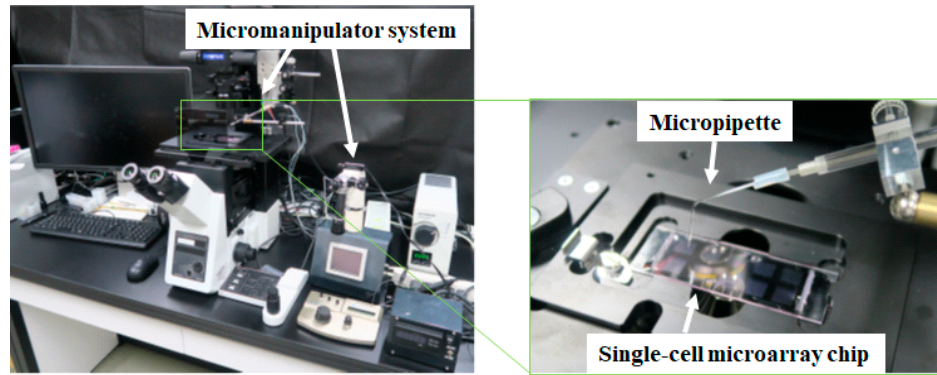
Figure 3. Photo of a micromanipulator system combined with a fluorescence microscope. Magnified picture shows a micropipette connected to the micromanipulator.